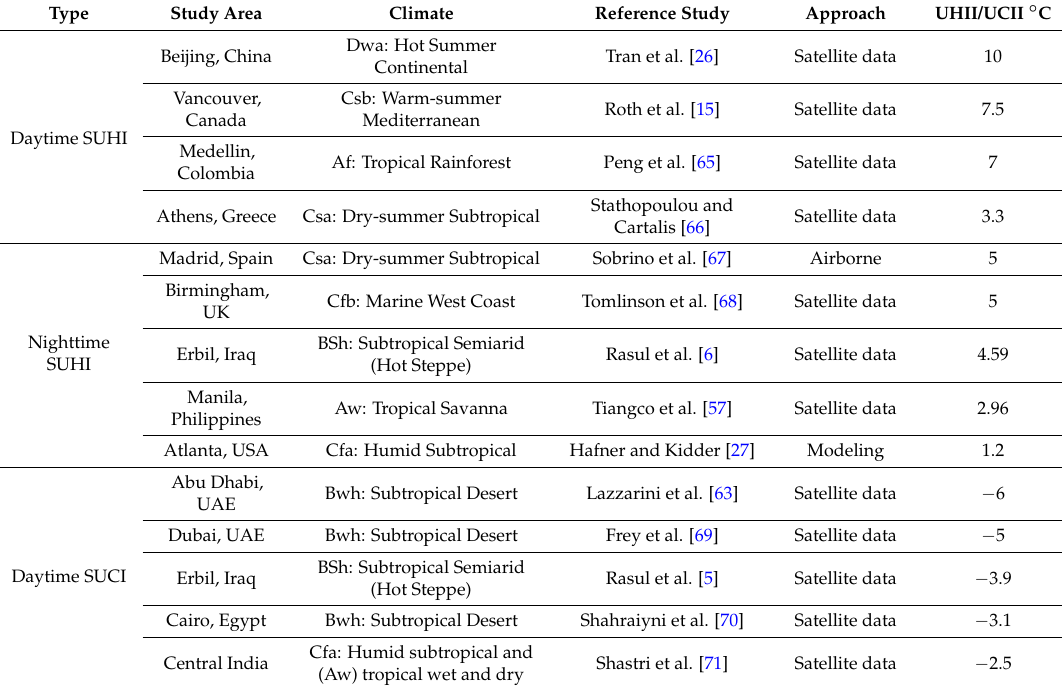
Table 1. A summary of surface UHII/UCII in different areas of the